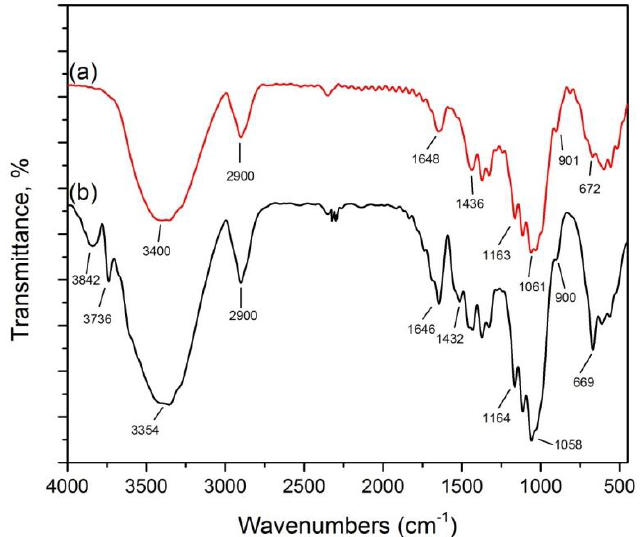
Figure 6. Microcrystalline cellulose: ( a ) untreated MCC; and ( b ) acid hydrolyzed in the presence of FeCl 3 catalyst.